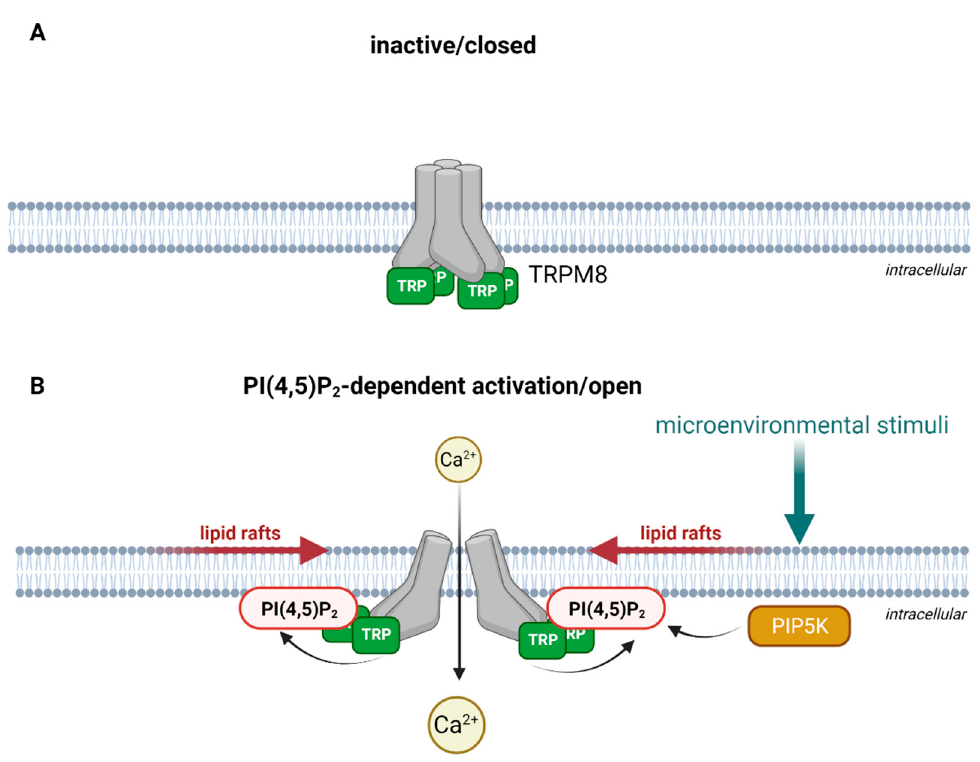
Figure 1. Schematic illustration of PI(4,5)P 2 -dependent activation as exemplified for TRPM8. ( A ) In the absence of PI(4,5)P 2 , the TRP-box holds the channel in a closed conformation. For simplification, other structural domains of TRPM8 are not illustrated. ( B ) Microenvironmental stimuli activate PI(4,5)P 2 production via phosphorylation of phosphatidylinositol 4-phosphate by PIP5K (phosphatidylinositol-4-phosphate 5-kinase) in lipid rafts. The interaction of phosphatidylinositol 4,5-bisphosphate (PI(4,5)P 2 ) the with the TRP-box activates TRPM8 and opens the channel for Ca 2+ entry. Created with BioRender.com